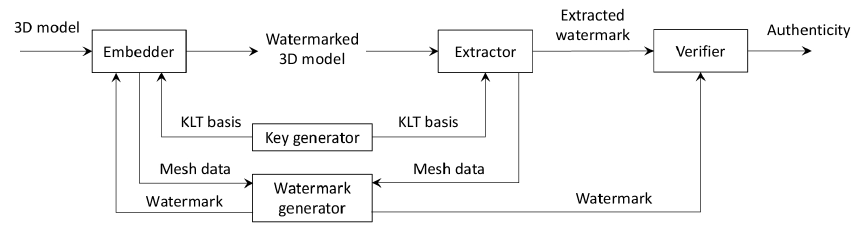
Figure 1. A high level scheme of the proposed